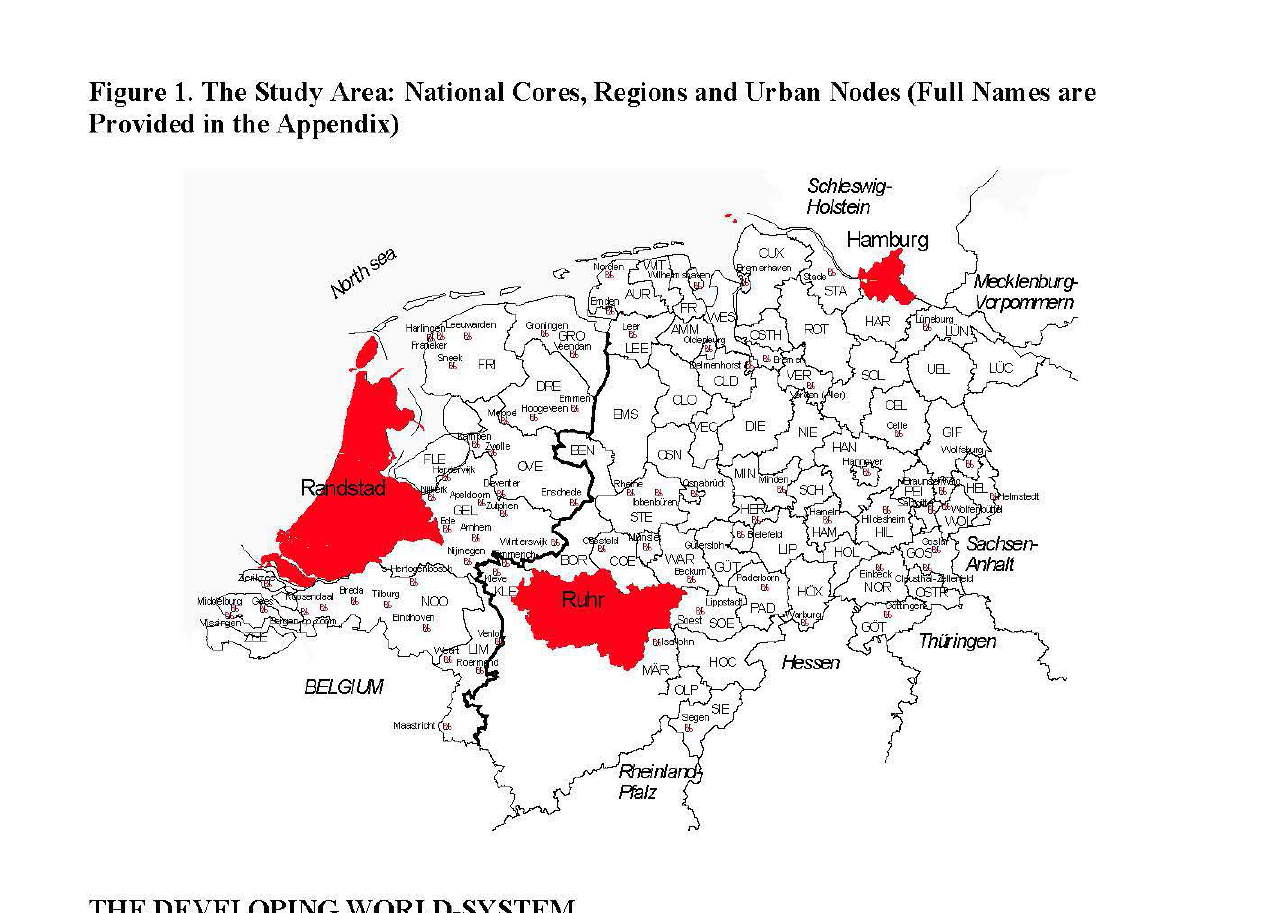
Figure 1. The Study Area: National Cores, Regions and Urban Nodes (Full Names are Provided in the